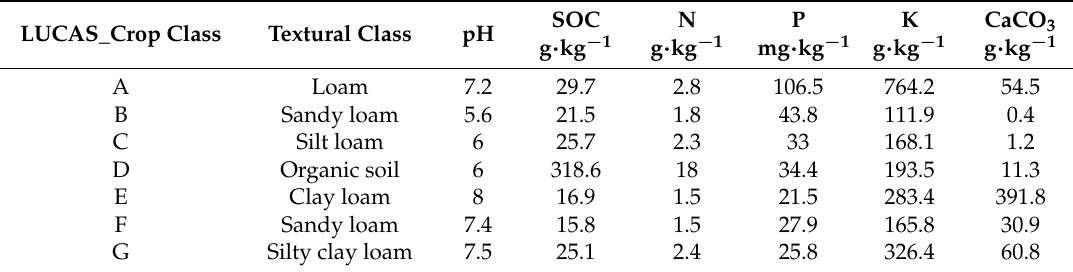
Table 1. Textural class and average values of the main soil variables for the seven classes of the LUCAS_crop